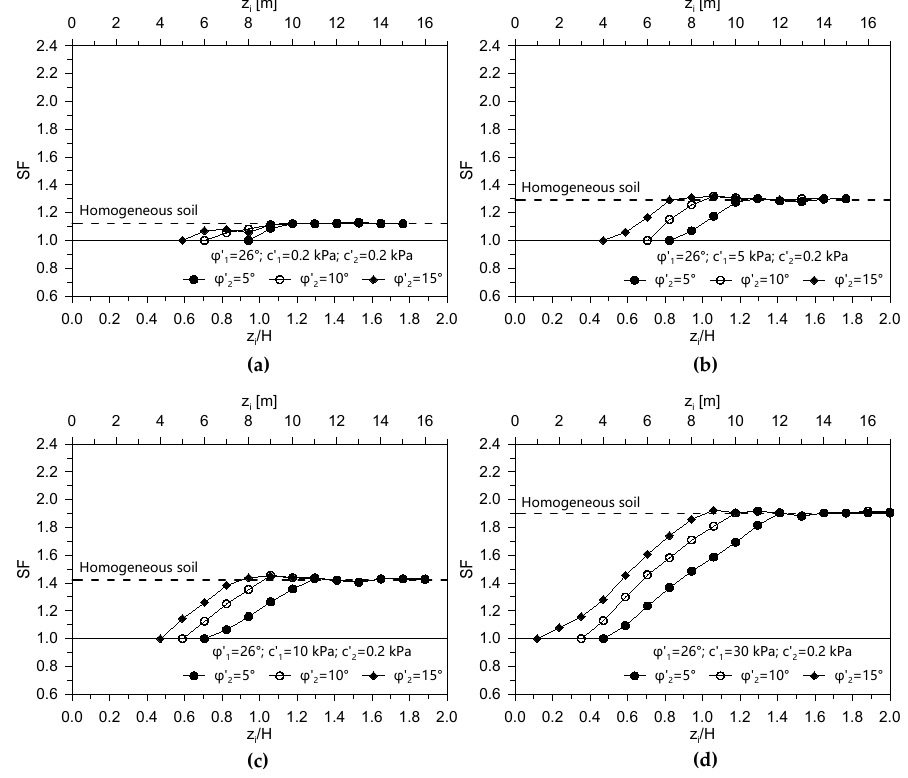
Figure 8. Safety factor SF as a function of the geometrical variable z i /H for φ′ 1 = 26° and c ′ 1 = 0.2 kPa ( a ), c ′ 1 = 5 kPa ( b ), c ′ 1 = 10 kPa ( c ) and c ′ 1 = 30 kPa ( d ), for different values of the shear strength angle φ′ 2 (5°, 10° and 15°).